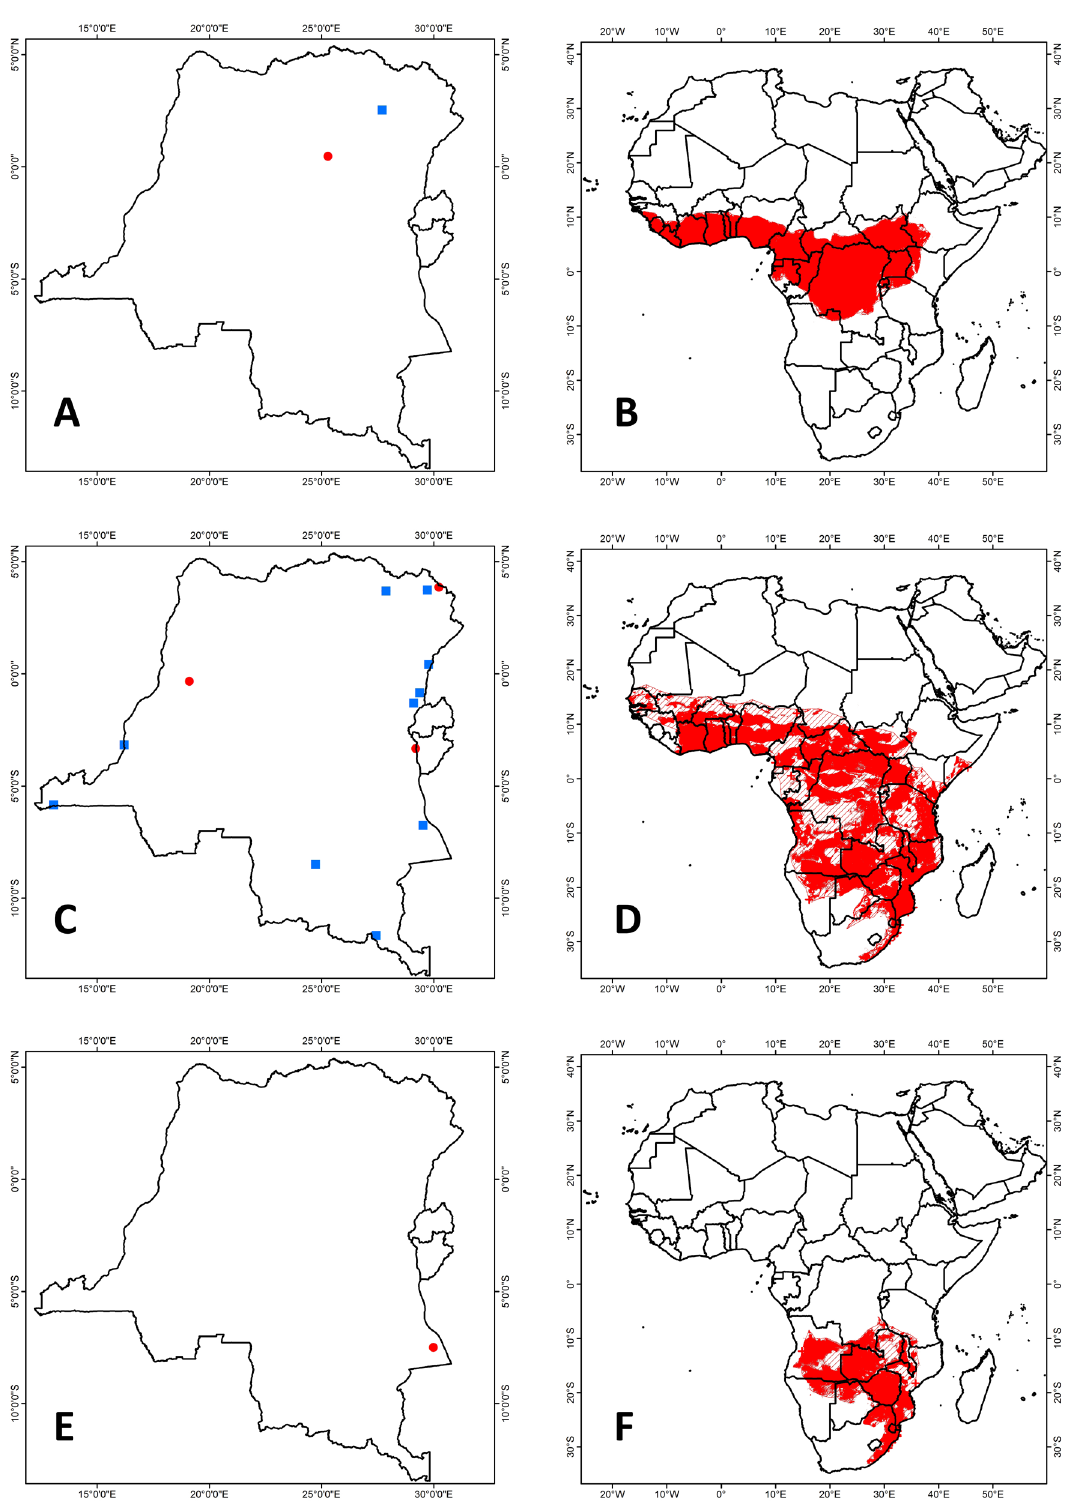
Fig. 40. Distribution maps. A–B . Glauconycteris superba Hayman, 1939. C–D . Glauconycteris variegata (Tomes, 1861). E–F . Hypsugo anchietae (Seabra, 1900). A, C, E. Distribution in the